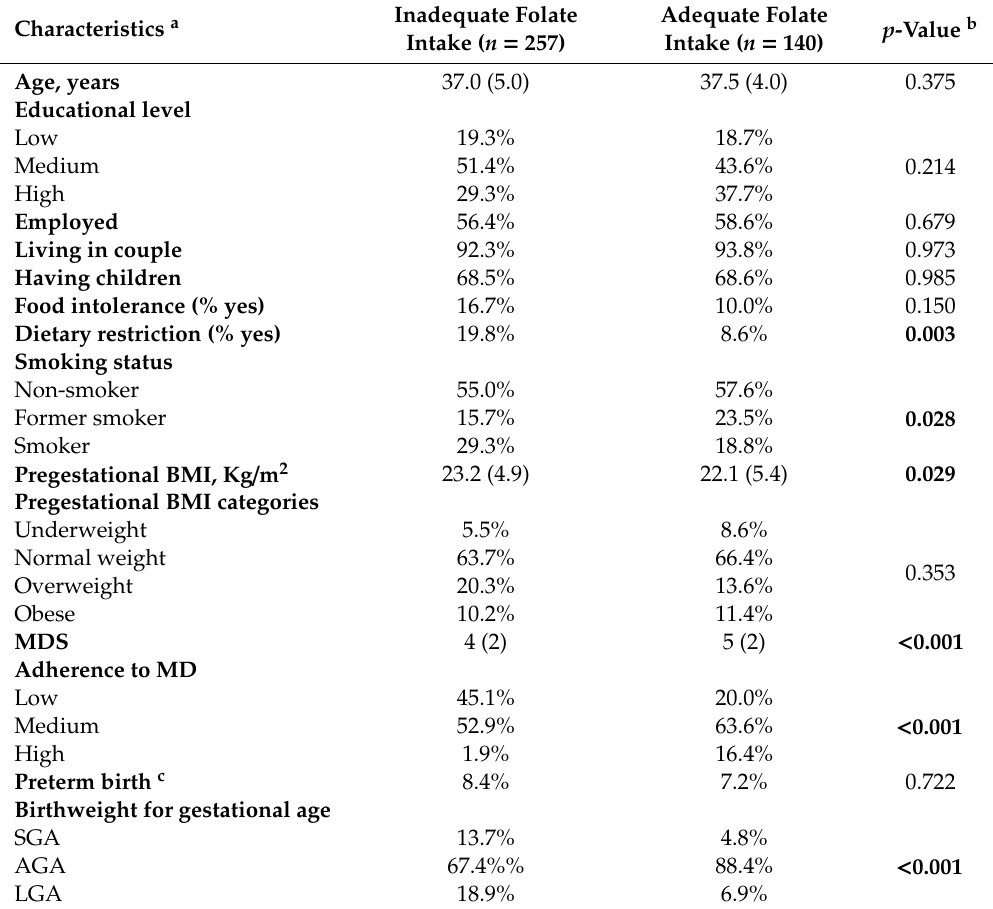
Table 1. Characteristics of pregnant women according to folate